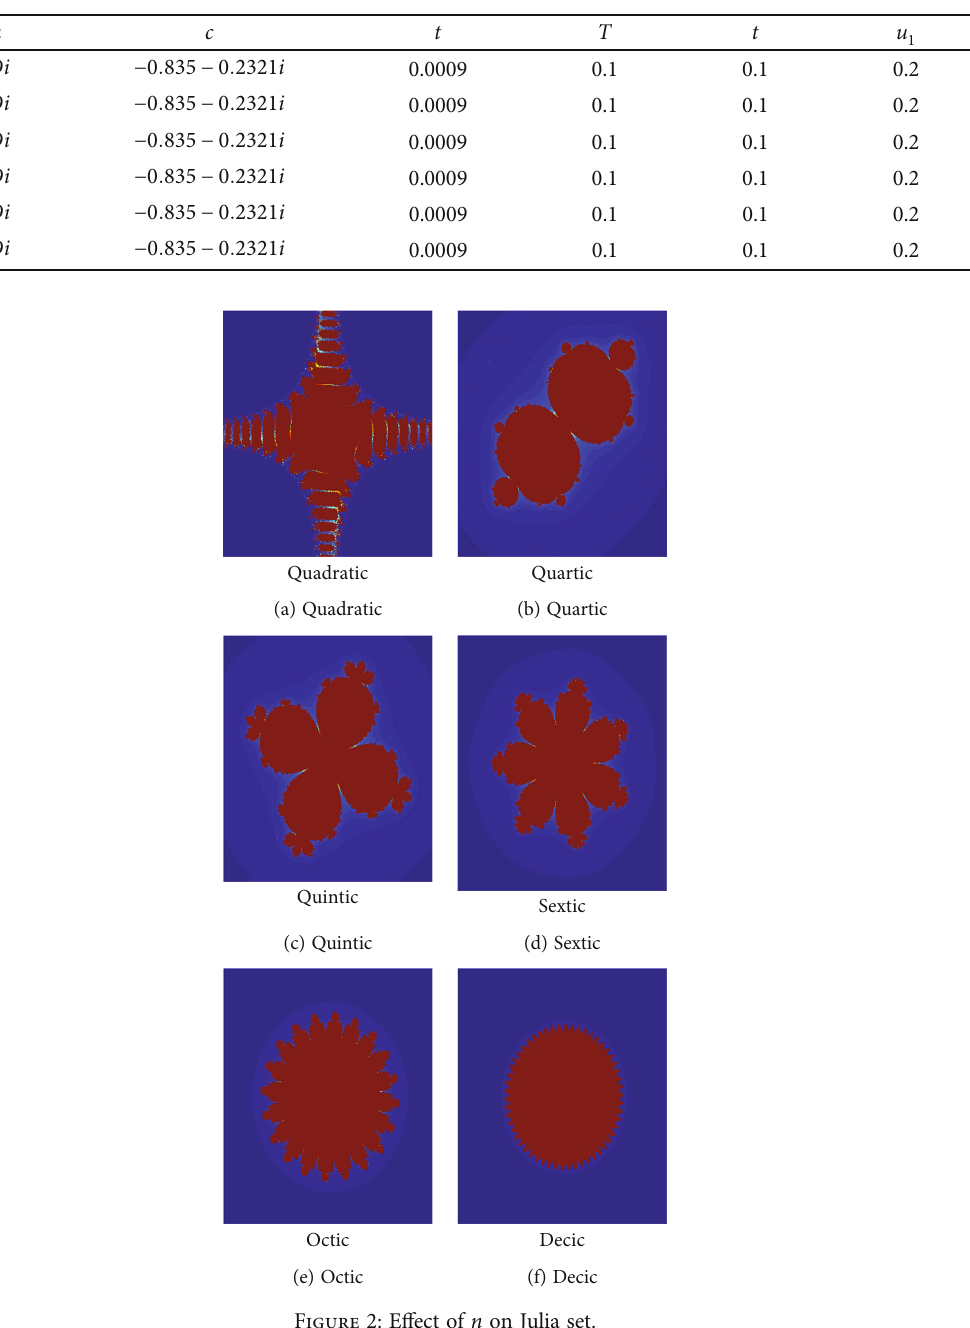
Table 1: Parameters for generation of Julia set for di ff erent values of n :